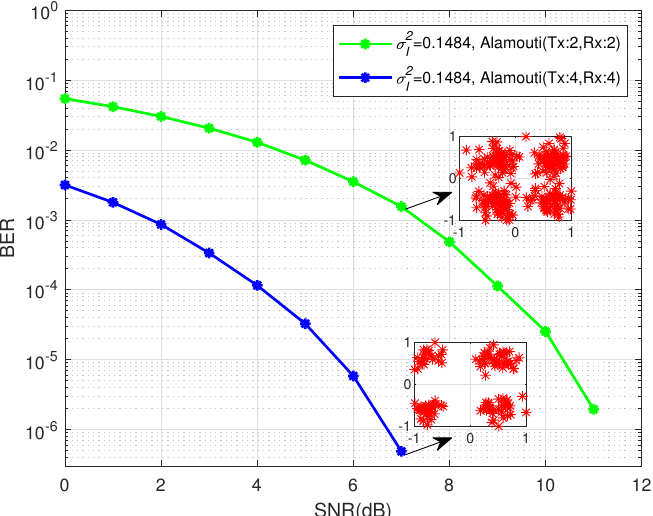
Figure 9. BER curves of systems with different diversity orders under weak turbulence conditions. Figure 10 shows the BER curves of the 4 × 4 STBC coding system under different turbulent current environments. The multiplexing system using part of the 4 × 4 STBC coding has an SNR of about 10 dB in a strong turbulent environment. This system is based on an underwater optical massive MIMO system, and some communication links adopt diversity technology, further improving the system’s effectiveness by ensuring the system’s